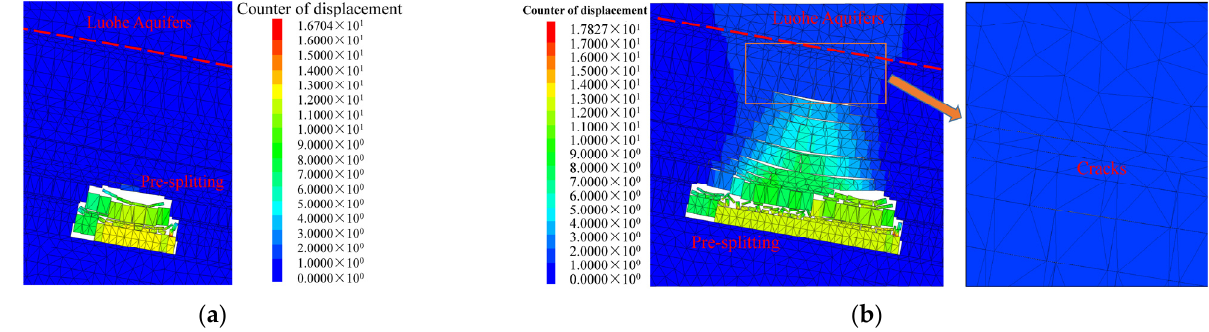
Figure 8. Roof caving process by pre-splitting at overlying strata at the mining length of ( a ) 50 m and ( b ) 100 m, respectively.